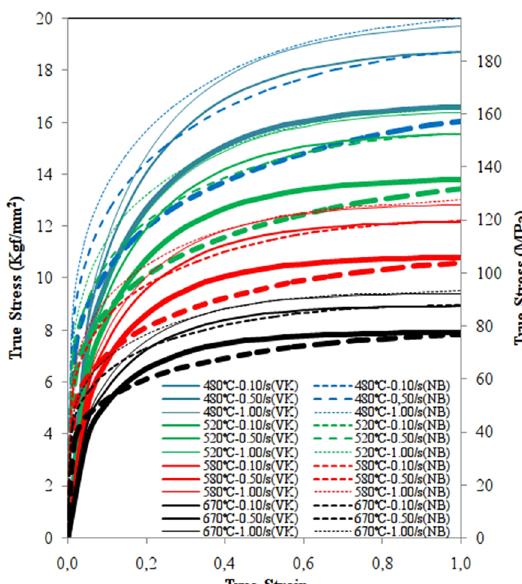
Figure 3. Stress vs. Strain curves obtained from Voce-Kocks (VK) and from the Norton-Bailey (NB) for 480, 520, 580 and 670 ºC and for strain rates of 0.1, 0.5 and 1 s -1 .